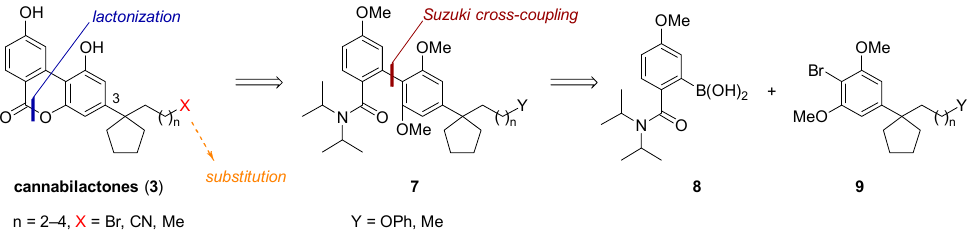
Figure 2. Chemical structures of the phytocannabinoids cannabinol (CBN), cannabidiol (CBD), and cannabinodiol